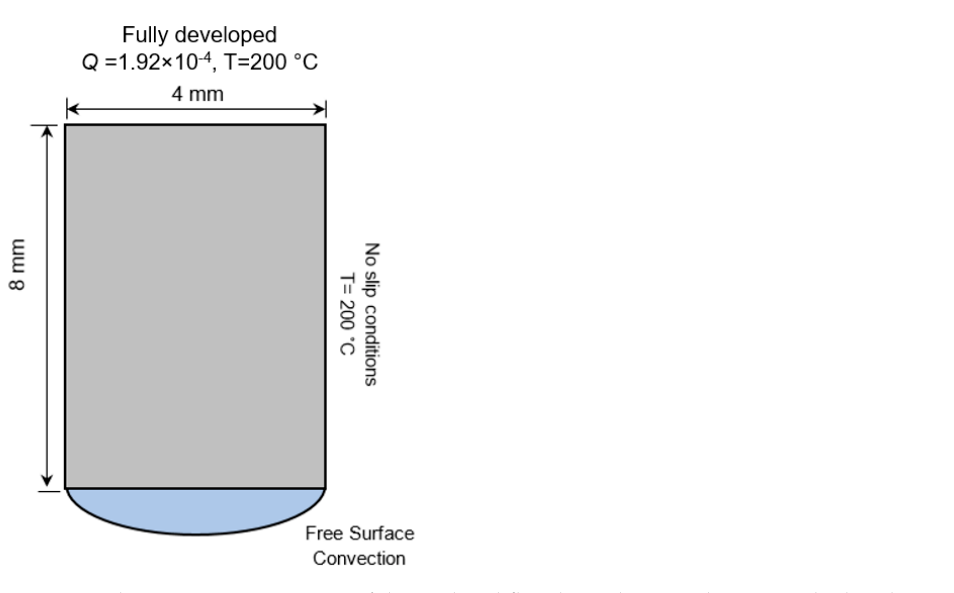
Figure 5. Schematic representation of thermal and flow boundary conditions applied to the model (not to scale). Table 1. ABS Material Properties [19].